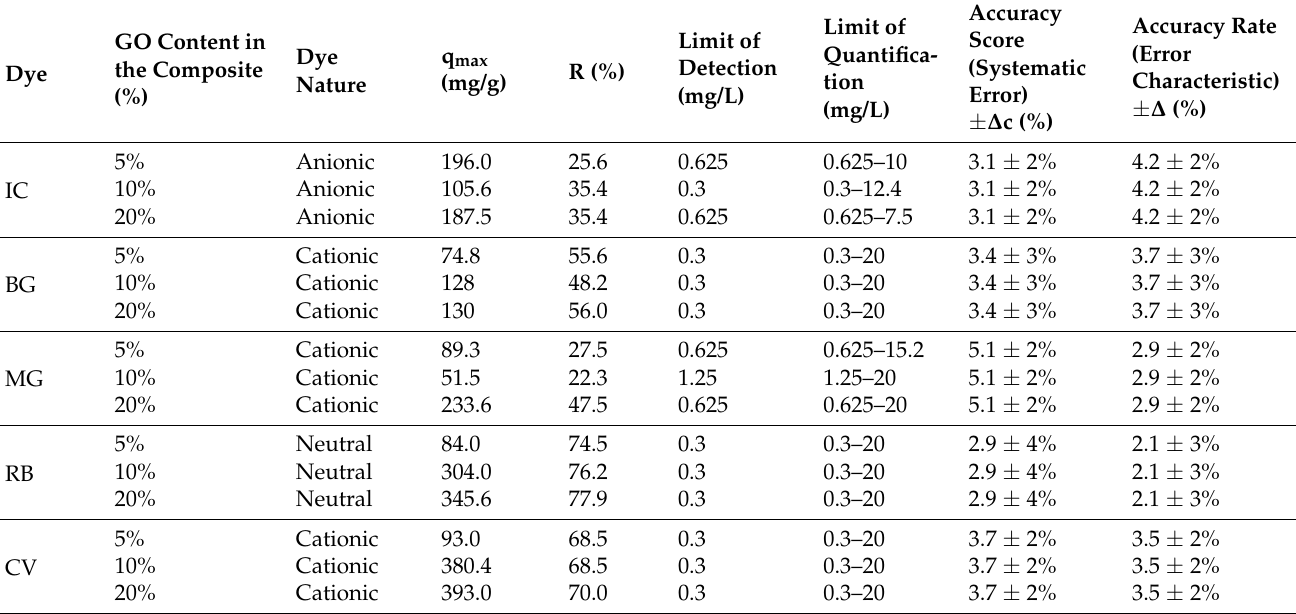
Table 8. Values of maximum adsorption and degree of extraction for studied dyes ( n = 3, p =